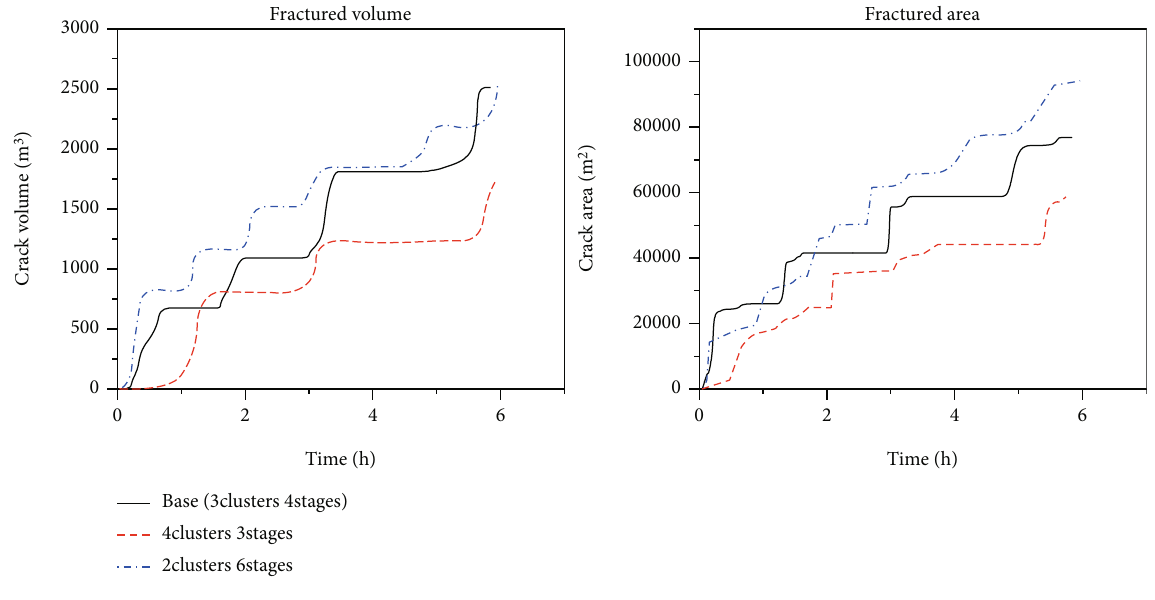
Figure 3: Evolutions of fractured volume and area for scenarios with di ff erent stage and cluster numbers.